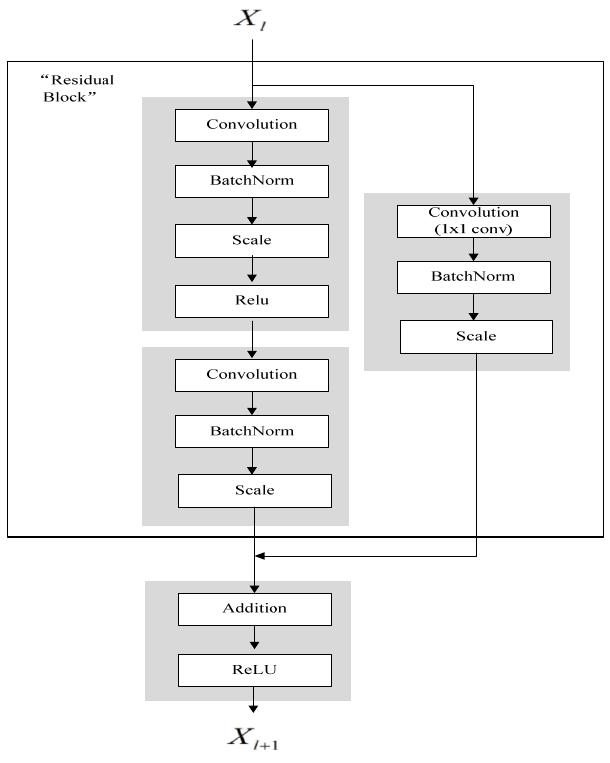
Figure 6. Residual block structure.